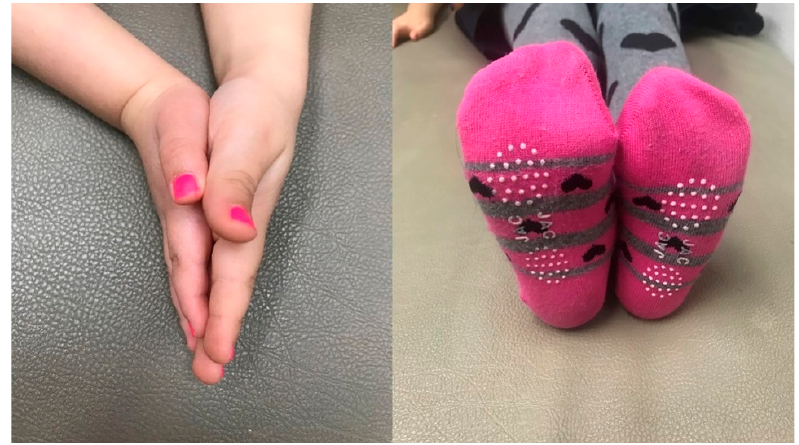
Figure 2. Enlarged right lower extremity and left upper extremity compared to the contralateral side.